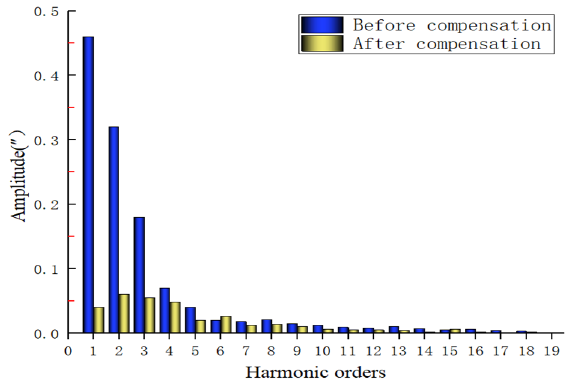
Figure 20. Spectrum results of the subdivision error before and after error compensation.